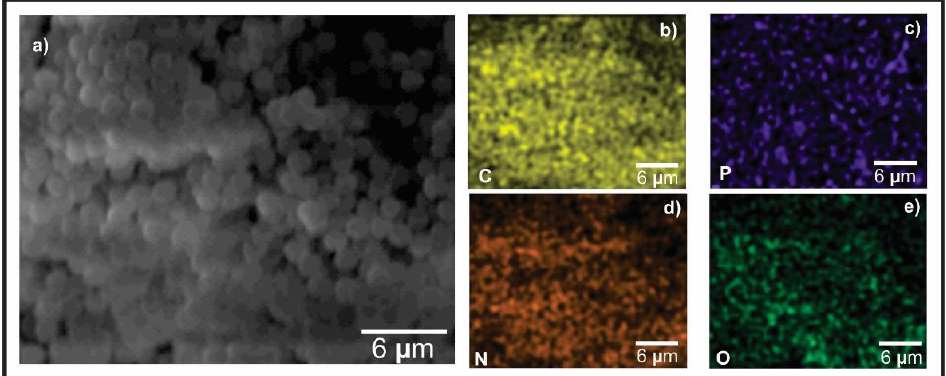
Figure 2. ( a ) Scanning electron microscopy (SEM) micrographs of the McMAPs and ( b ) size distri- bution histogram for the microcapsules. ( c ) Energy-dispersive X-ray spectrometry (EDS) analysis.